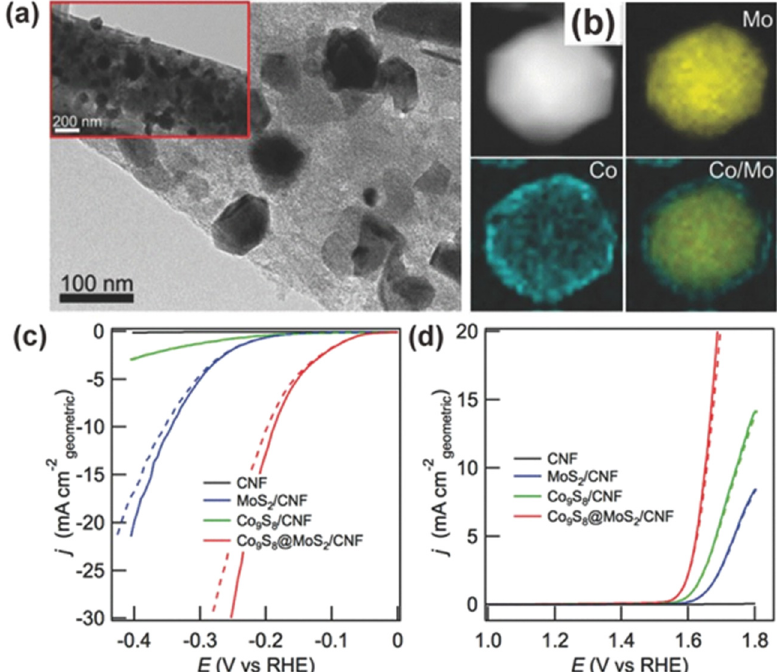
Figure 10: ( a ) TEM fi gures of Co 9 S 8 @MoS 2 /CNF. ( b ) STEM - EDS mapping of the same catalyst. ( c ) HER performance of CNF, MoS 2 /CNF, Co 9 S 8 / CNF, and Co 9 S 8 @MoS 2 /CNF at 2 mV s − 1 in acid solution ( 0.5 M H 2 SO 4 ) ( d ) OER e ffi ciency of CNF, MoS 2 /CNF, Co 9 S 8 /CNF, and Co 9 S 8 @MoS 2 / CNF at 2 mV s − 1 in basic solution ( 1 M KOH ) . All the outcomes illustrated by solid lines were associated with iR losses. The dotted lines display the initial events. Reprinted from [ 160 ] , copyright 2015, Wiley -